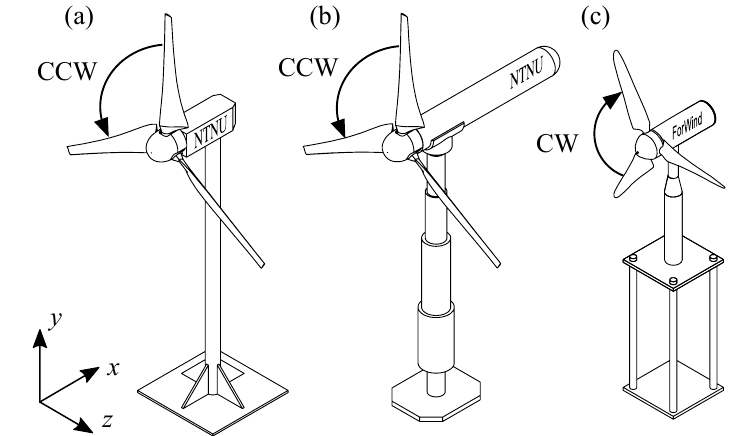
Figure 1. Sketches of the model wind turbines with reference coordinate system, (a) NTNU turbine LARS1 rotating in counterclockwise direction (CCW), (b) NTNU turbine T2 rotating in counterclockwise direction (CCW), (c) ForWind turbine rotating in clockwise direction (CW).